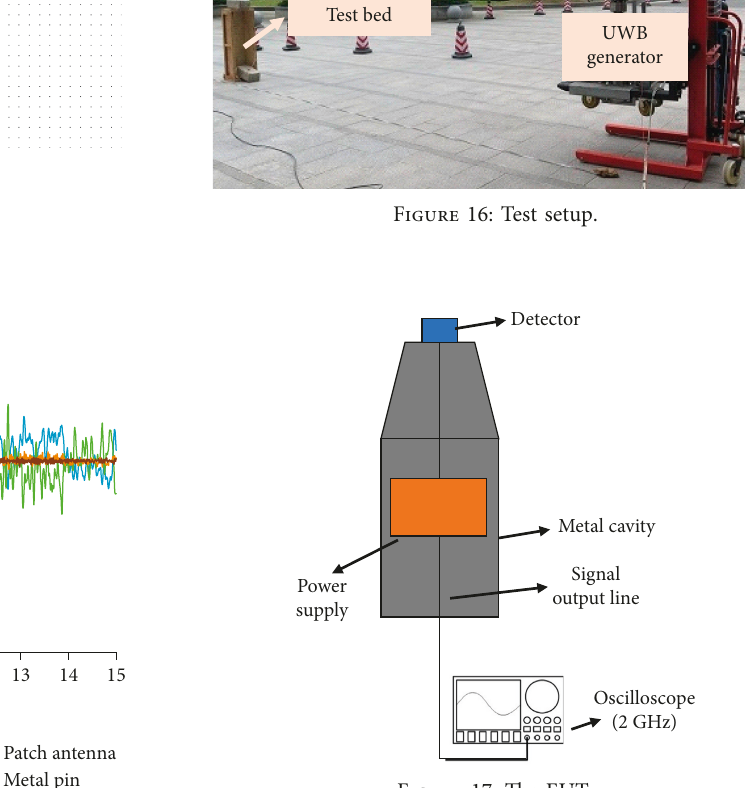
Figure 17: The EUT.